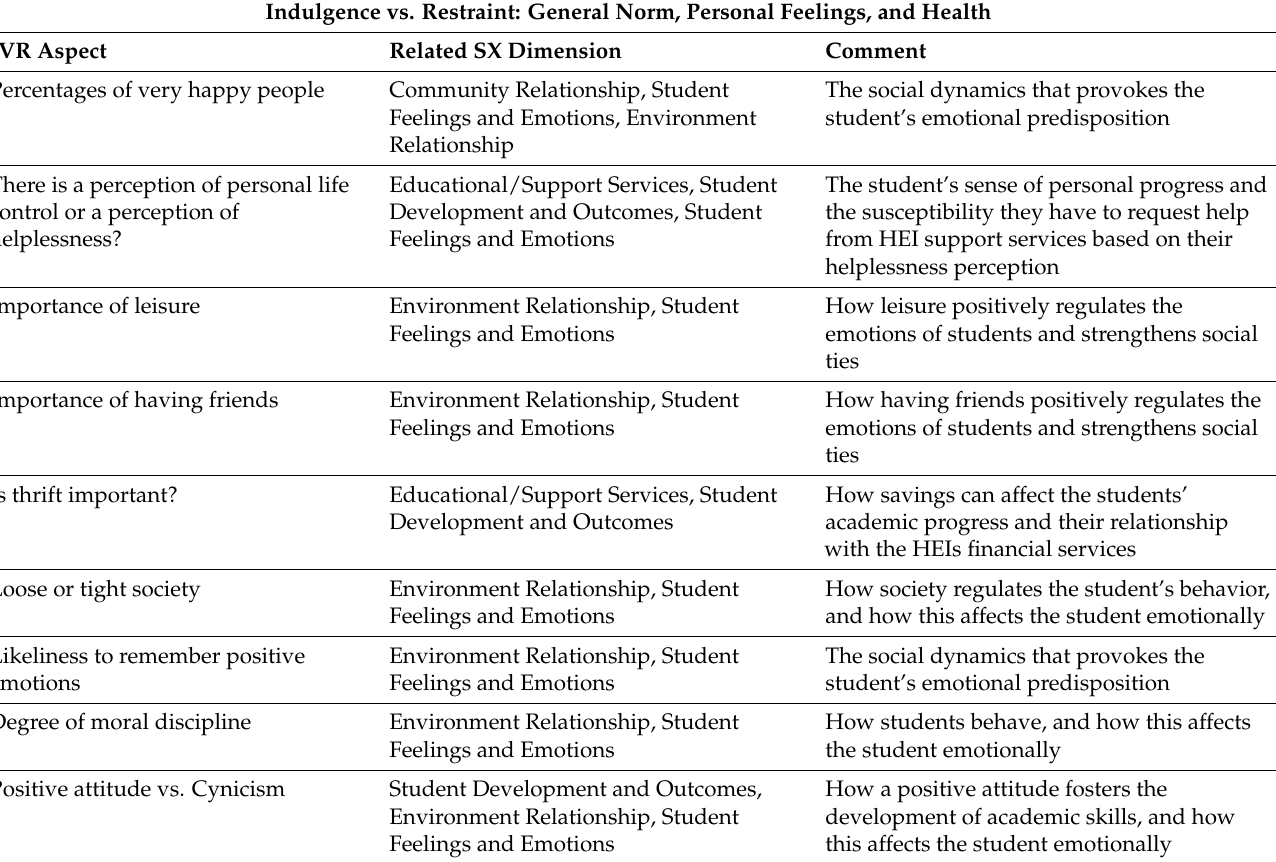
Table 6. General norm, personal feelings, and health aspects of indulgence/restraint societies in